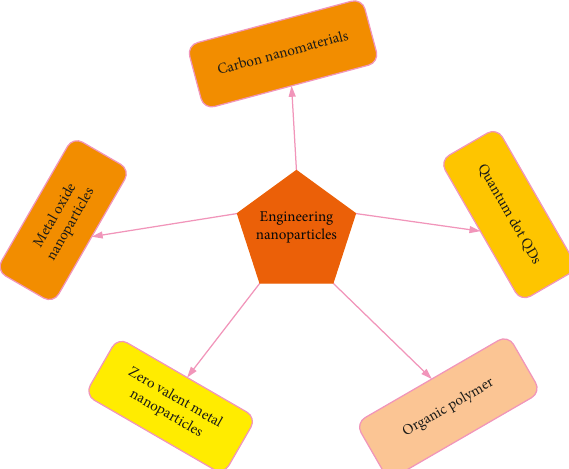
Figure 1: Schematic diagram of nanoparticle